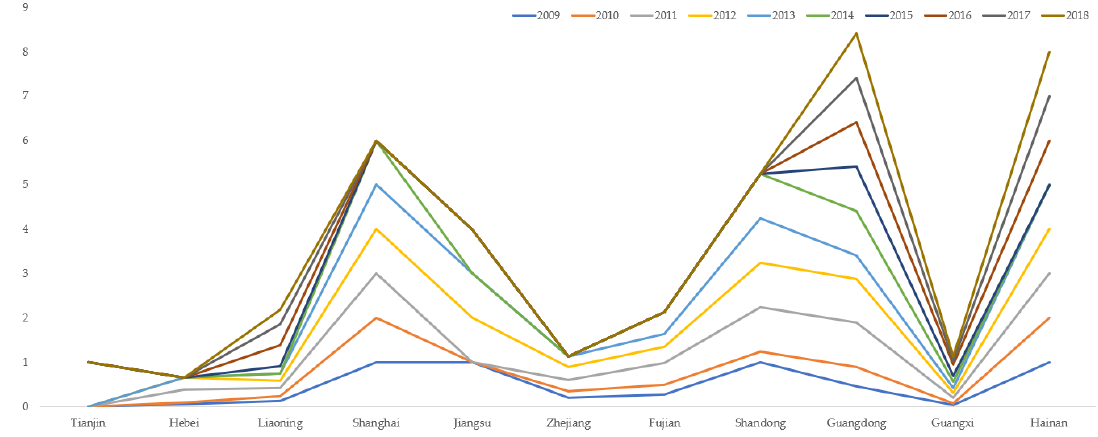
Figure 5. Marine economic development efficiency stacked chart.